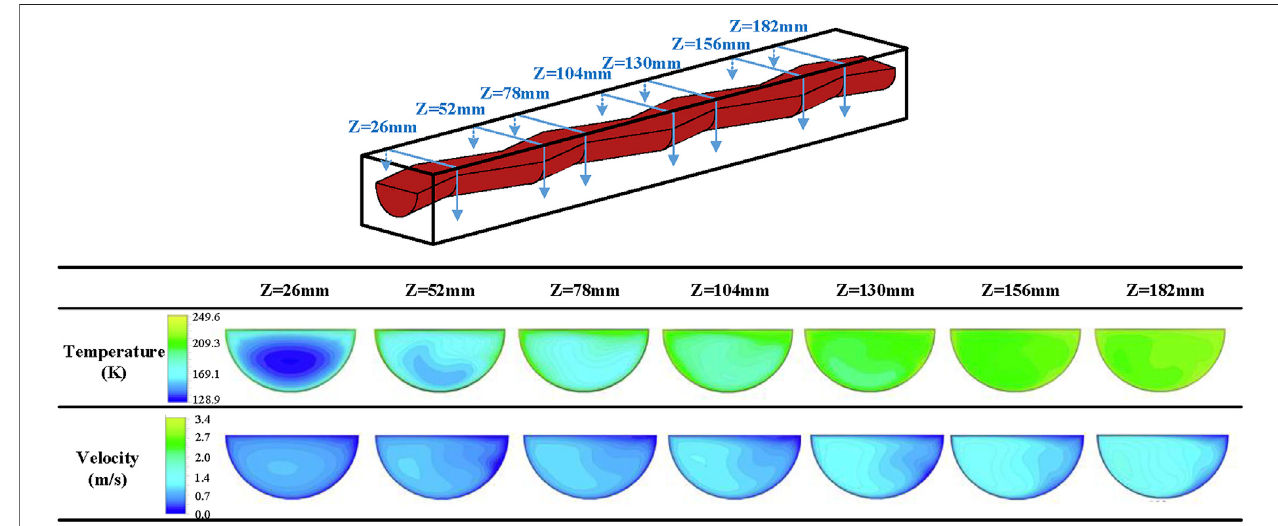
FIGURE 4 | Flow and heat transfer characteristics of the zigzag-channel PCHE with LNG (Bai et al., 2020).